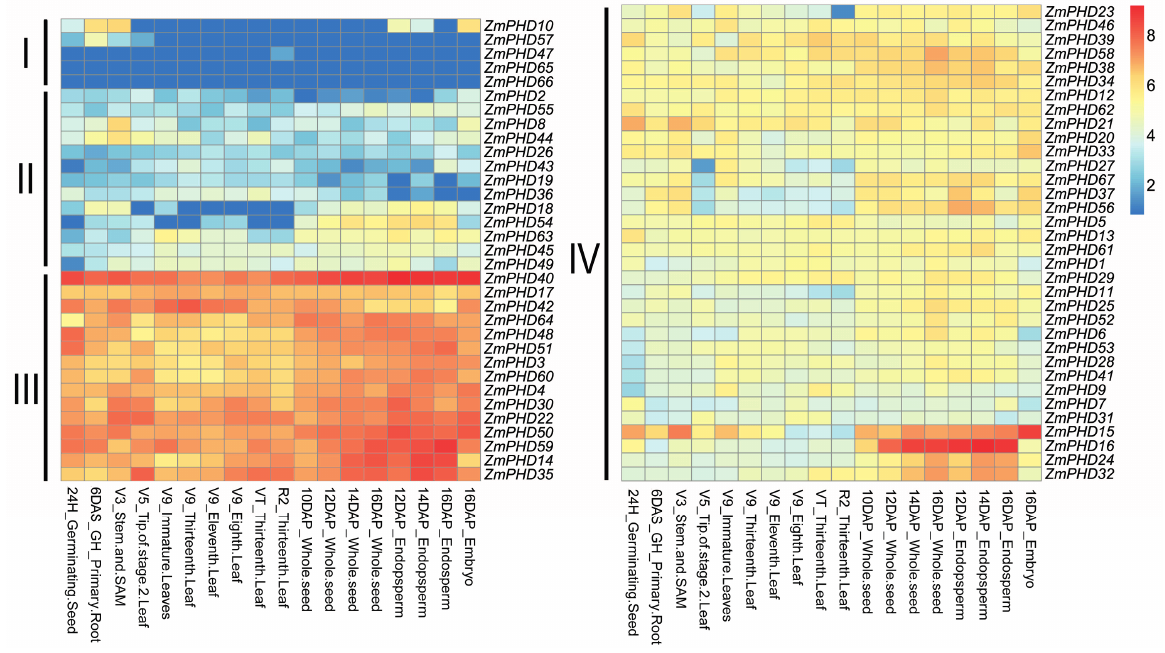
Figure 7. Expression profiles of maize PHD genes across different tissues. Genes highly or weakly expressed in the tissues are colored red and blue, respectively. Classes I to IV indicates the different levels of gene log2 -transformed expression. The gradually change of the color indicates different expression level of PHD genes, and yellow color stands for middle expression